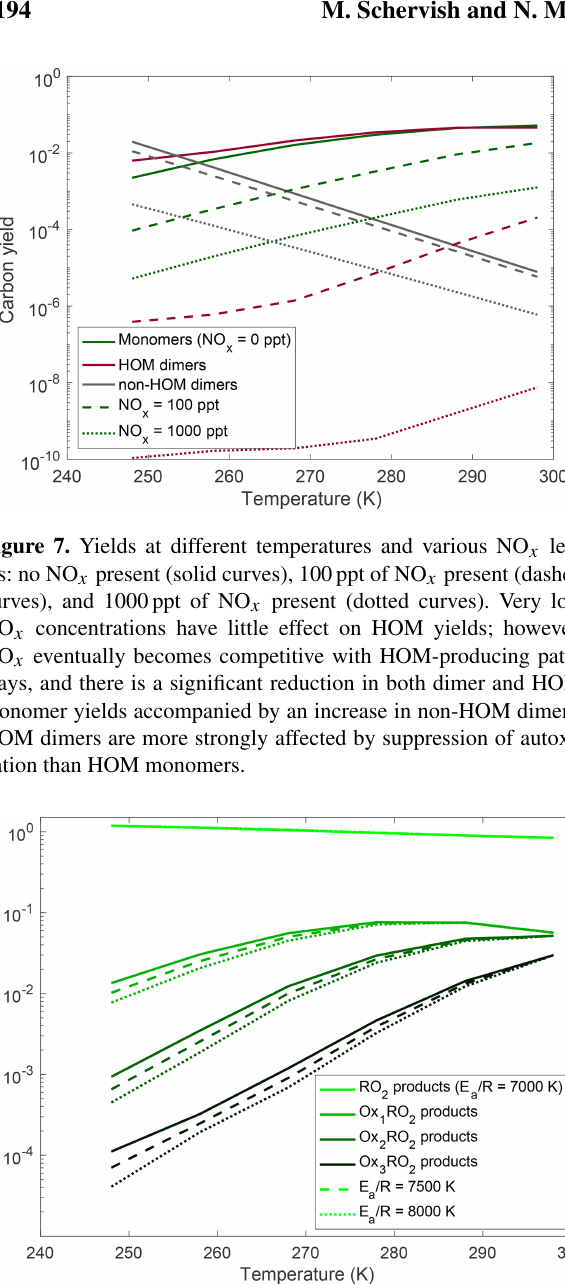
Figure 8. Variation in carbon yields of the OxRO 2 s with tempera- ture for different autoxidation barrier heights. Here the autoxidation rate coefficient at 298K is fixed at 0 . 01s − 1 , and we vary the activa- tion energy. The dashed curve shows the results for the rate coeffi- cient in our base-case simulation. The solid curve has a lower acti- vation energy and thus a weaker temperature dependence, while the dotted curve has a higher activation anergy and thus a stronger tem- perature dependence. As expected autoxidation is suppressed more quickly as temperature drops when the activation energy is higher; this translates to lower HOM yields.